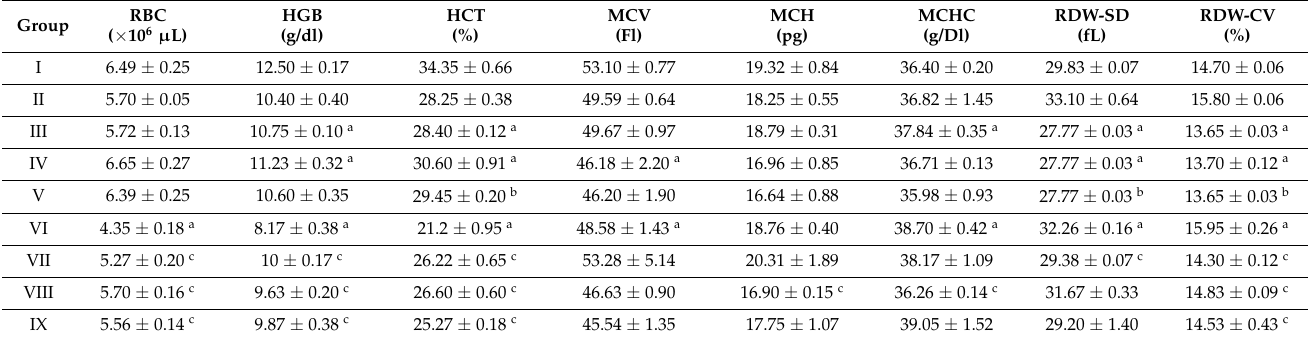
Table 4. Changes in erythrocytes and blood indices of mice after 2 weeks of the treatment.